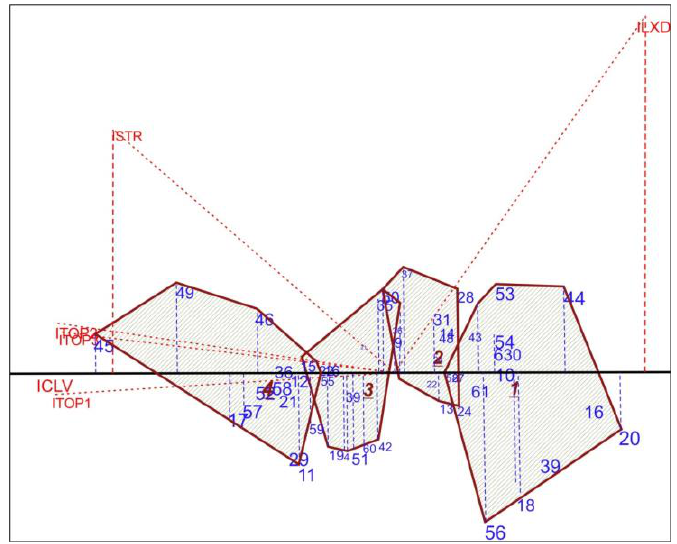
Figure 9. Interactive drawing and study of HJ-biplots and clustering of texts belonging to data set 1, with 61. Blue numbers mean texts. Red strings mean latent variables.